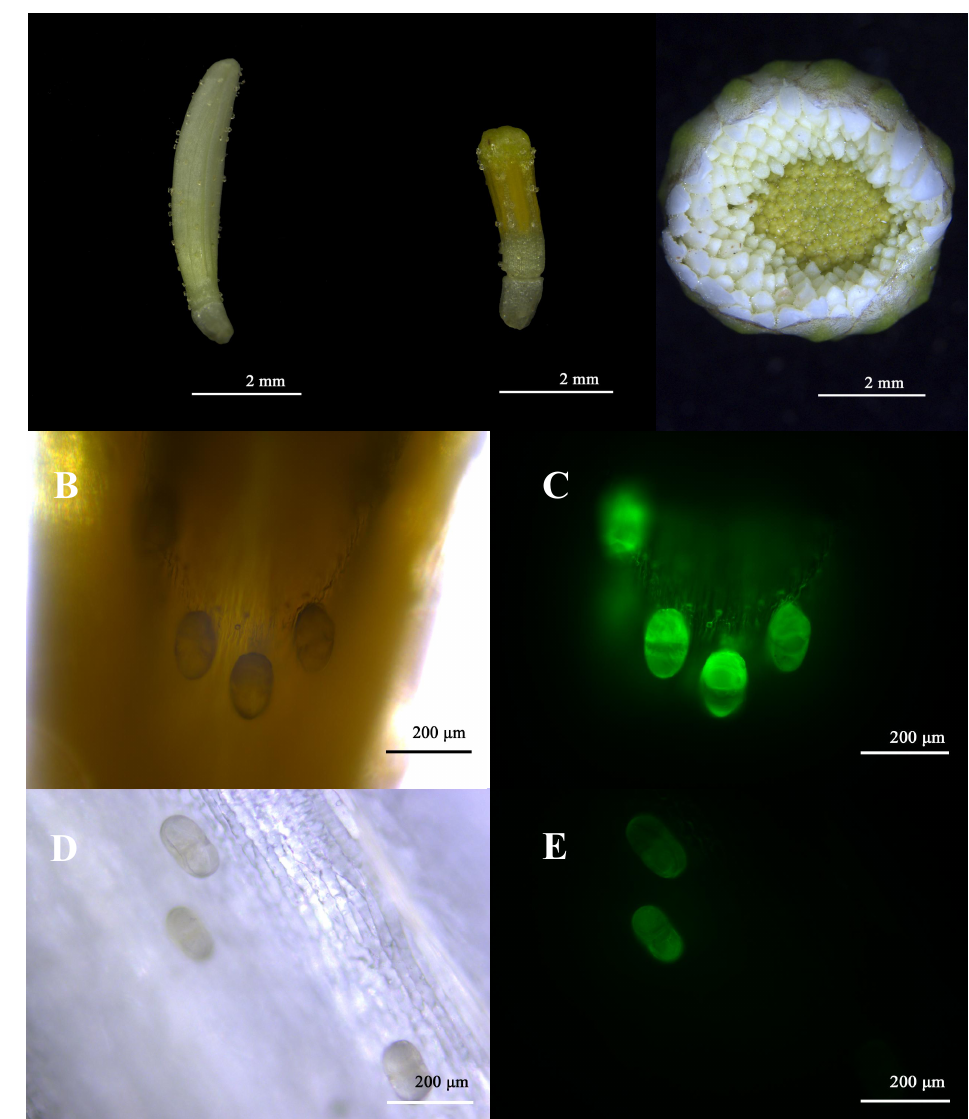
Figure 4. Representative ‘HBJ’ cultivar showing a flowerhead in the break bud stage with an external whorl of ray florets and central whorls of disc florets ( A ); from left to right: ray florets, disc florets and flowerheads. Also shown are trichomes distributed on the ray florets ( B , C ) and disc florets ( D , E